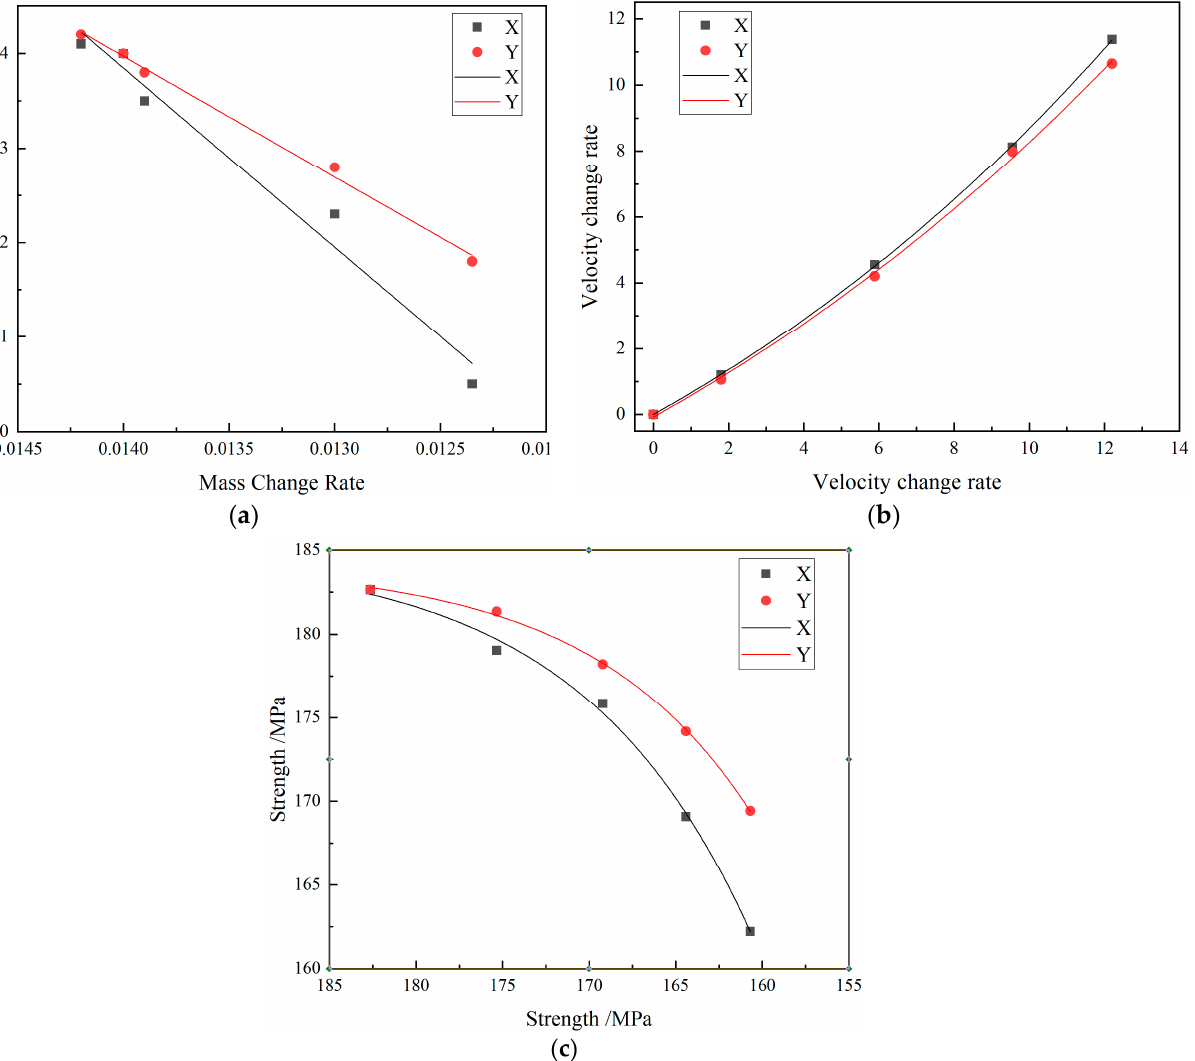
Figure 10. Correlation after X and Y with Z. ( a ) Correlation between the mass change rates. ( b ) Correlation between the velocity change rates. ( c ) Correlation between the uniaxial compressive strengths.